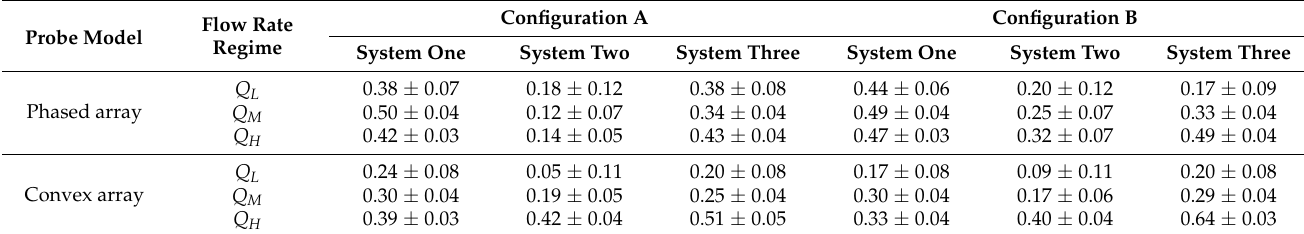
Table 12. Velocity Measurements Accuracy parameter results (mean ± SD).